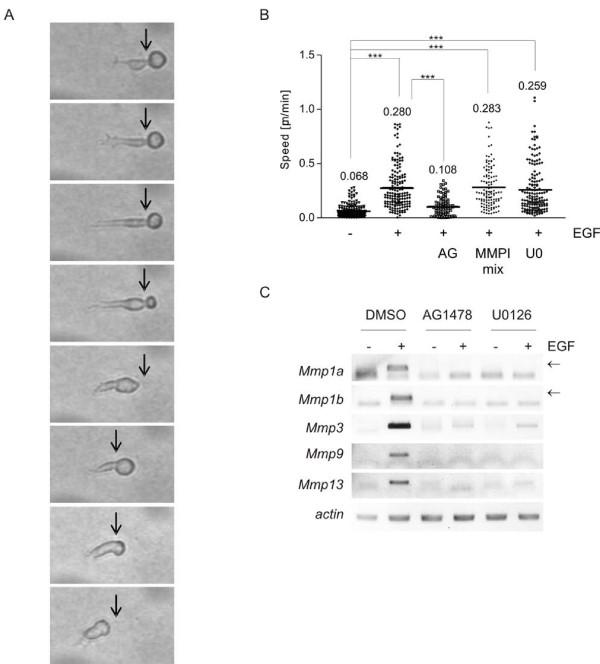
EGF induces MMP-independent amoeboid migration in Hm cells. A: Hm cells were embedded in a three-dimensional collagen matrix and overlaid with starving medium containing EGF. The pictures are a detail magnification of Additional file 3, Movie S1 and show the migrative behaviour of a single cell that was photographed eight times consecutively with a time interval of 4 min between the pictures. The arrow indicates areas of dense matrix where the cell has to contract its cell body. B: Analysis of the speed of Hm cells migrating in a three-dimensional collagen gel. Cells were embedded into collagen in the presence of DMSO, AG1478, U0126 and a mixture of MMPI 9/13 and GM6001 (Ilomastat). Where indicated, cells were overlaid with EGF-containing medium. Graphs display the speed of single cells that was calculated from the time-lapse movies, and the mean speed for each condition is indicated. The following numbers of cells were examined: ctrl., EGF, EGF + U0126: n = 161 (for each); EGF + AG1478: n = 78; EGF + MMP inhibitors: n = 120. ***: p < 0.0001. C: Hm cells were embedded in collagen matrix and stimulated with EGF as described above. The supernatant contained DMSO, AG1478 or U0126, respectively. After 8 h, where maximal stimulation was seen before, whole collagen gels were used for RNA isolation and RT-PCR analysis of the indicated genes. In case of Mmp1a and -1b a lower, unspecific DNA band was seen, which was presumably due to oligonucleotide multimers that can form in the absence of specific template. The specific bands for MMP1a and -1b are indicated by an arrow.